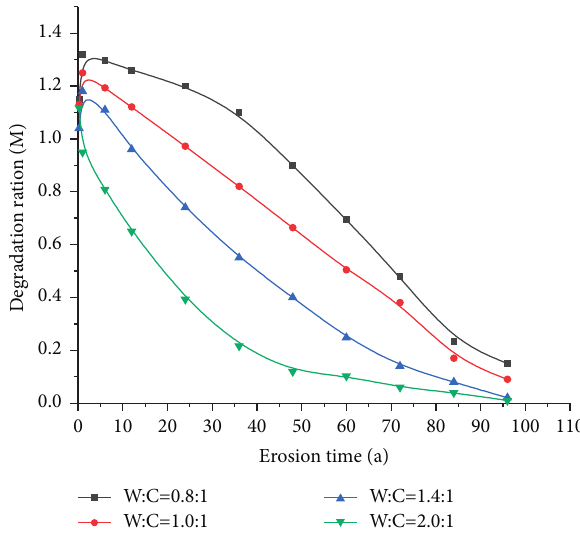
Figure 5: The weakening law of grouted body degradation ratio with